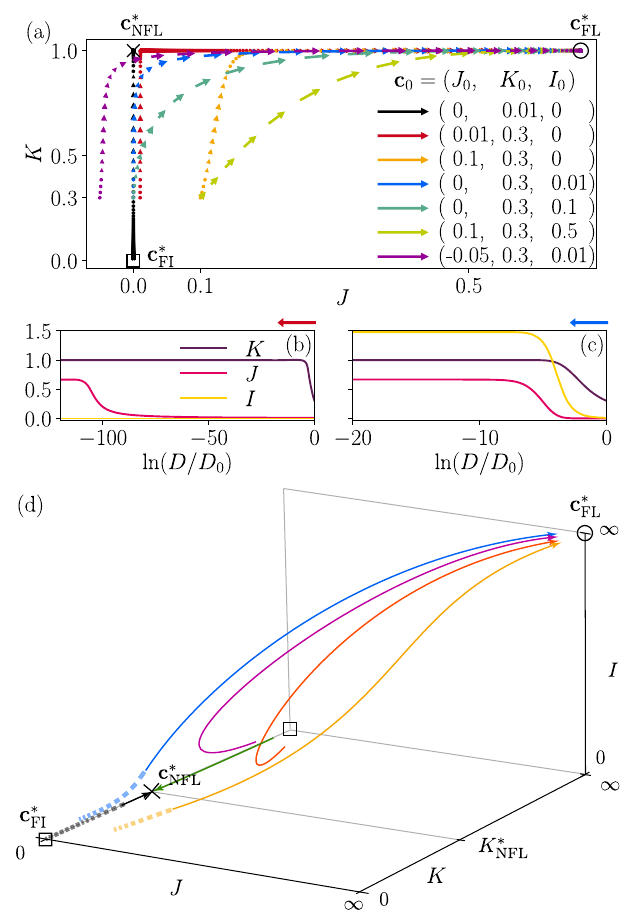
FIG. 1. (a) RG flow of the coupling vector c ¼ ð J; K; I Þ (projected into the J - K plane), obtained by solving the weak-coupling RG equations (2) [Eqs. (8 – 10) of Ref. [9]] for various initial values, c 0 ¼ ð J 0 ; K 0 ; I 0 Þ . Arrows depict the gradient vector − ½ d = ð d ln D Þ(cid:2)ð J; K Þ at equal steps of ln D . (b,c) Weak-coupling RG flow of c ð D Þ for (b) c 0 ¼ ð 0 . 01 ; 0 . 3 ; 0 Þ [red arrows in (a)] and (c) (0,0.3,0.01) [blue arrows in (a)]. (d) Qualitative depiction of the conjectured RG flow in the full J - K - I space, for all non-negative couplings. Fat, faint dashed lines show the solutions c ð D Þ of the weak-coupling equations (2), initialized at K 0 ≪ K (cid:3) ð > 0 ; 0 Þ (yellow), or ð 0 ; > 0 Þ (blue), and plotted only in the weak-coupling regime [beyond the latter, Eqs. (2) lose validity]. Solid lines, drawn by hand, qualitatively show the flow expected beyond the weak-coupling regime, including trajectories initialized at K 0 ≫ K (cid:3) with ð J 0 ; I 0 Þ ¼ ð 0 ; 0 Þ (green), ð > 0 ; 0 Þ (orange), or ð 0 ; > 0 Þ (purple). The black squares, cross, and circle depict fixed points. Published by the American Physical Society under the terms of the Creative Commons Attribution 4.0 International license. Further distribution of this work must maintain attribution to the author(s) and the published articles title, journal citation, and DOI.